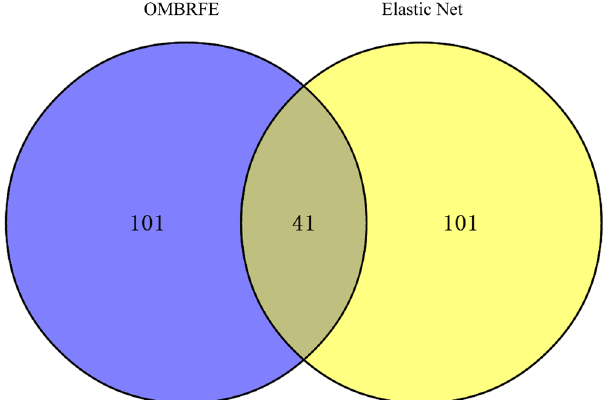
Figure 5. Venn diagram is shown for the feature genes identified by OMBRFE and Elastic Net.